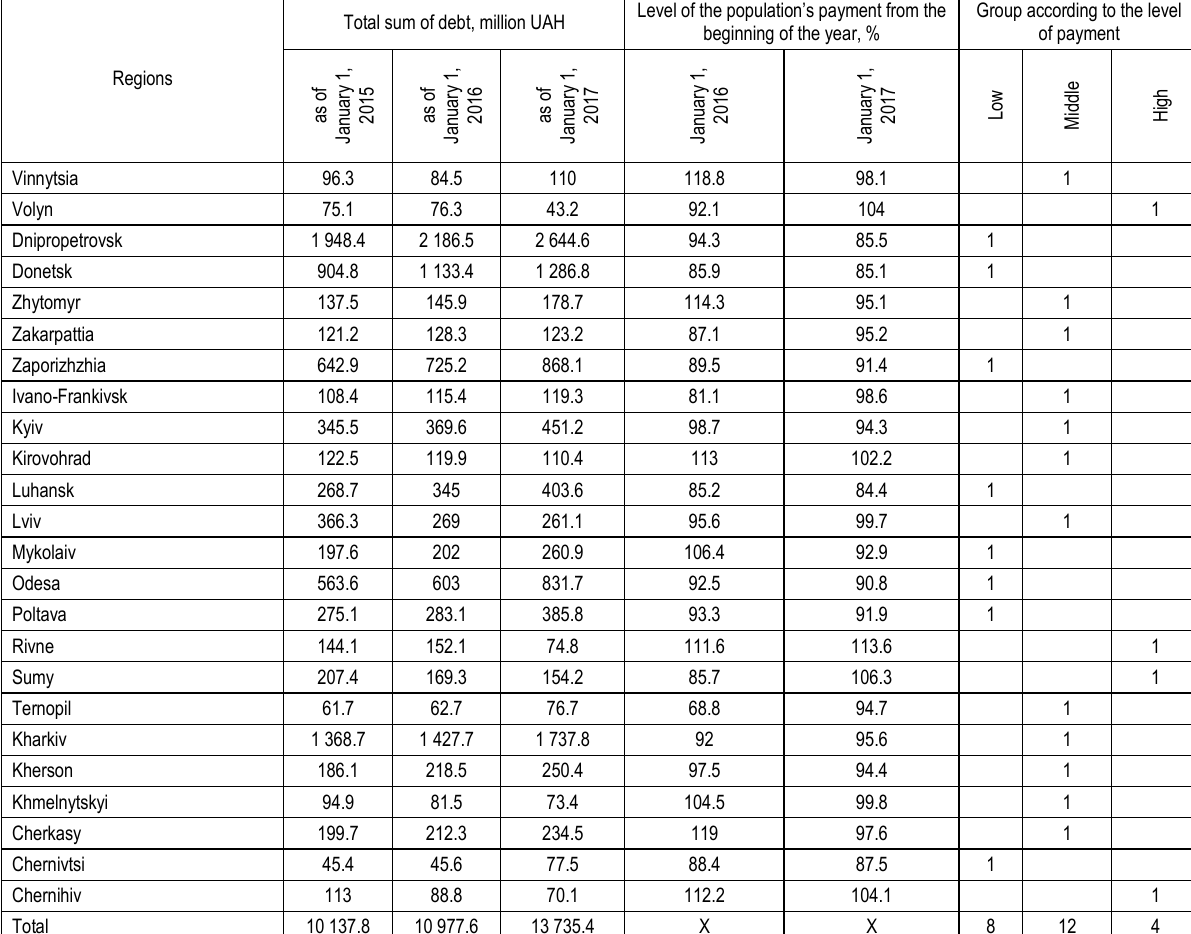
Table 4 . Growth of population’s debt for housing and utility services in the period 2014−2016 Group according to the level Total sum of debt, million UAH Level of the population’s payment from the beginning of the year, % of Regions